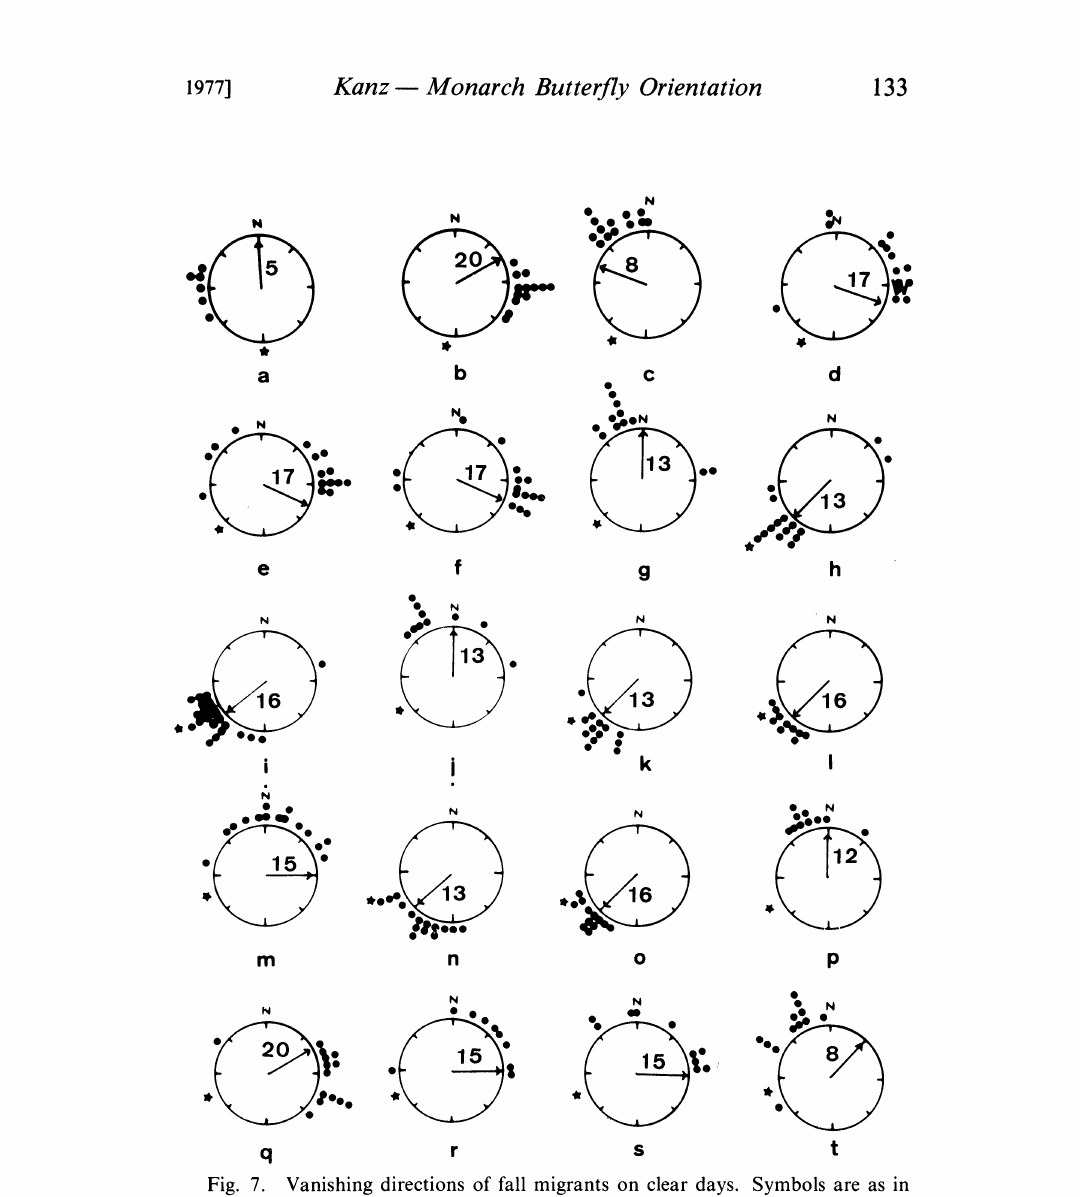
Fig. 7. Vanishing directions of fall migrants on clear days. Symbols are as in Fig. 5. Most releases flew down-wind but distributions for north and northeast winds are tighter than those for southerly winds. See text for